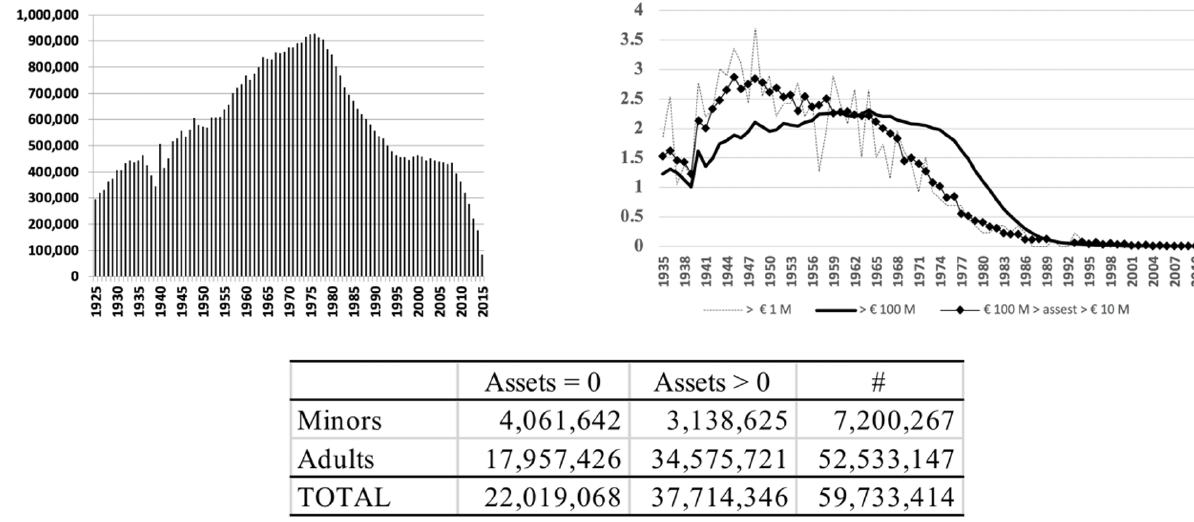
Figure 4. Net worth by